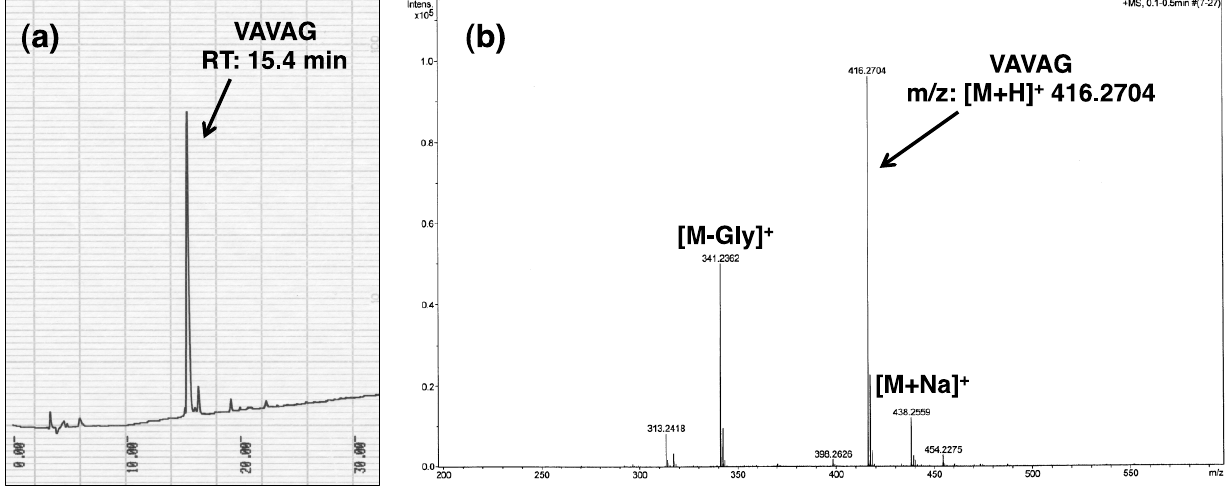
Figure 4. ( a ) Analytical HPLC profile; and ( b ) mass spectra of Val-Ala-Val-Ala-Gly-OH (VAVAG) obtained by MW assisted solid phase synthesis in water using nanoparticles. Elution was carried out for over 40 min at a flow rate of 1 mL/min with a linear gradient from 95:5 to 55:45 mixture of 0.05% aqueous TFA and 0.05% TFA in acetonitrile. Column: 5C18-Ar-II (2.4 × 250